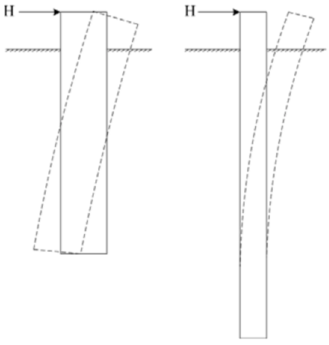
Figure 1. Rigid vs. flexible pile submitted to lateral load.